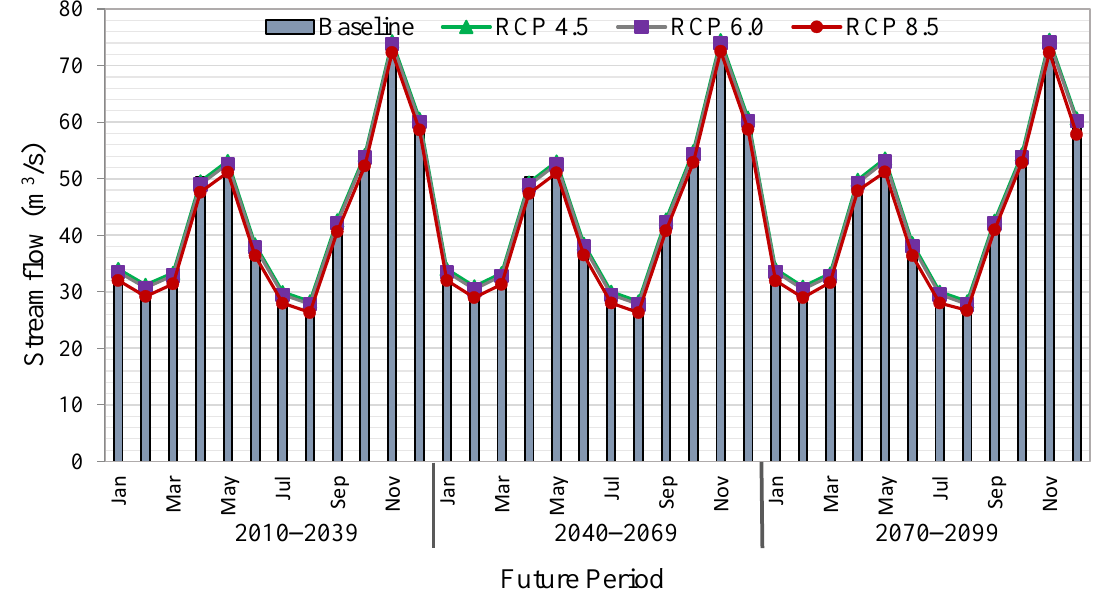
Figure 7. Projected mean monthly streamflow for three future periods of 2010–2039, 2040–2069, and 2070–2099 relative to the baseline period of 1976–2005 using three Representative Concentration Pathway (RCP) scenarios (RCPs 4.5, 6.0, and 8.5).